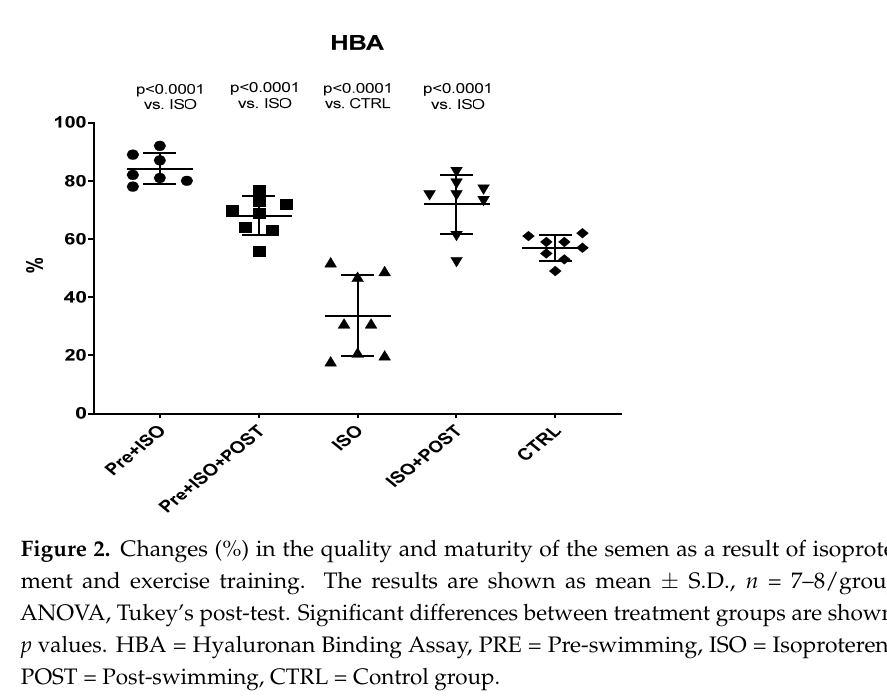
( b ) Figure 3. ( a ) The effects of isoproterenol treatment and exercise training on interleukin-6 (IL-6) con- centrations of the semen, expressed as ng/mg protein. ( b ) The effects of isoproterenol treatment and exercise training on tumor necrosis factor-alpha (TNF- α ) concentrations of the semen, expressed as ng/mg protein. The results are shown as mean ± S.D., n = 7–8/group, one-way ANOVA, Tukey’s post-test. Significant differences between treatment groups are shown with exact p values. PRE = Pre-swimming, ISO = Isoproterenol injection, POST = Post-swimming, CTRL = Control group, TNF- α = tumor necrosis factor-alpha, IL-6 = interleukin-6. 3.3.2. Measurement of Testicular TNF- α and IL-6 Concentrations As shown in Figure 4a, a significant increase in IL-6 concentration within the testis was detected in the ISO-treated group compared to CTRL animals. Swimming exercise